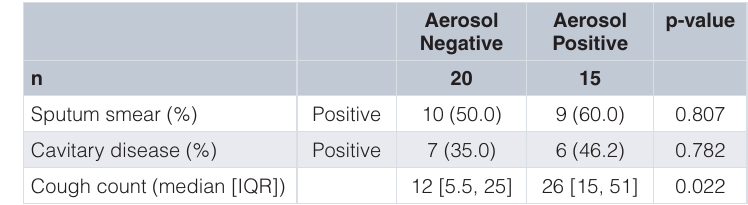
Table 2. Traditional predictors of infectiousness stratified by Aerosol Culture. Categorical variables were compared using Fisher exact tests and continuous variables using a Wilcoxon rank sum